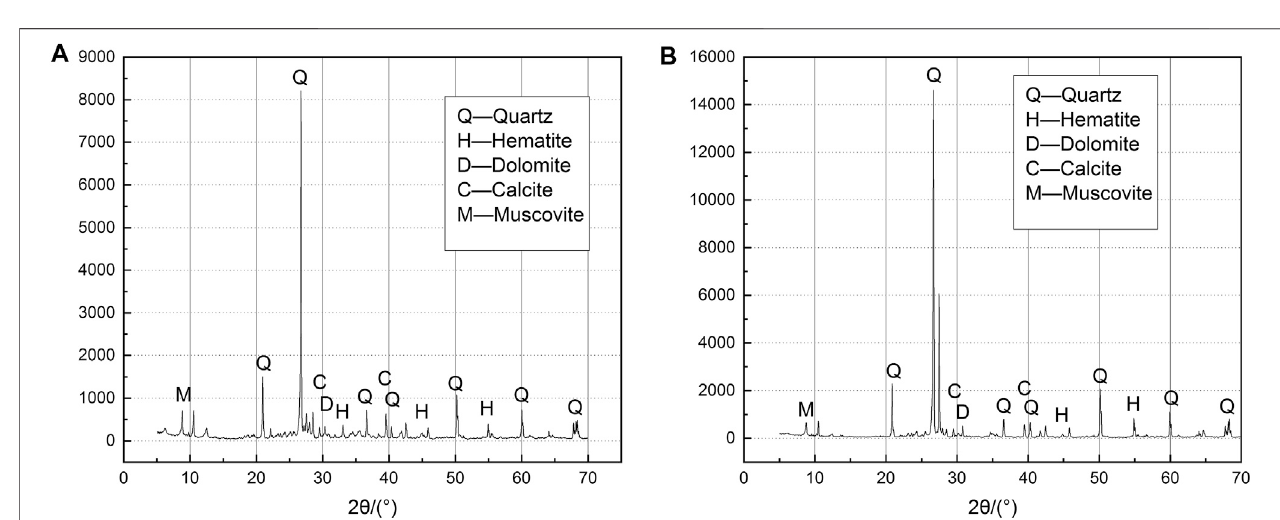
FIGURE 3 | XRD spectrum results of tailings: (A) the ultra- fi ne tailings; (B) the classi fi ed tailings.